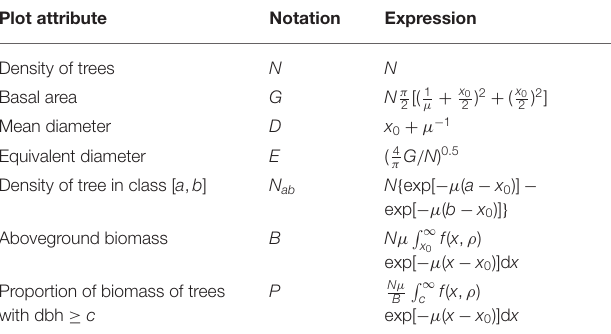
TABLE 1 | Expression of the plot attributes when the diameter distribution at plot level is modeled by an exponential distribution with parameter µ , given